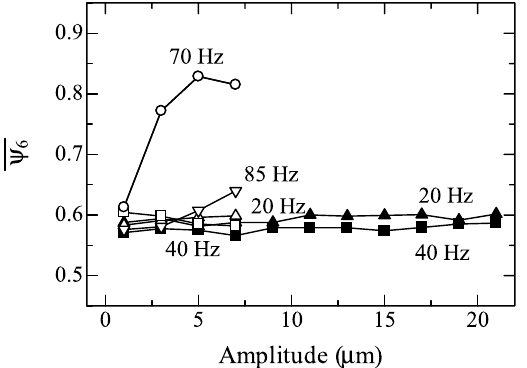
Figure 2. Averaged bond orientational order parameters after 30-s oscillations with increasing amplitude at different frequencies. Open symbols represent the experimental results when oscillations are applied to a sample with changing the frequency in the order of 20, 40, 85, and 70 Hz; the order is 1 μ m at 20 Hz, 3 μ m at 20 Hz, … , 7 μ m at 20 Hz, 1 μ m at 40 Hz, … , and 7 μ m at 70 Hz. Filled symbols represent the experimental results for different